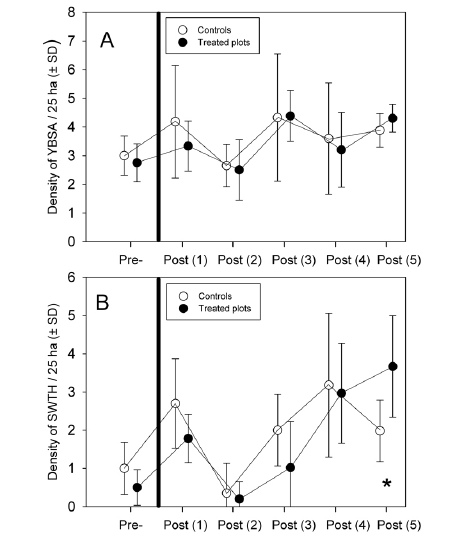
Fig. 3 . Mean (±SD) density of Northern Parula, Setophaga americana (A) and Black-throated Green Warbler, Setophaga virens (B) in treated plots and controls during one year preharvest and the first five years postharvest. The solid line delineates the pre- from the postharvest years and asterisks (*) indicate significant year-specific treatment effects.